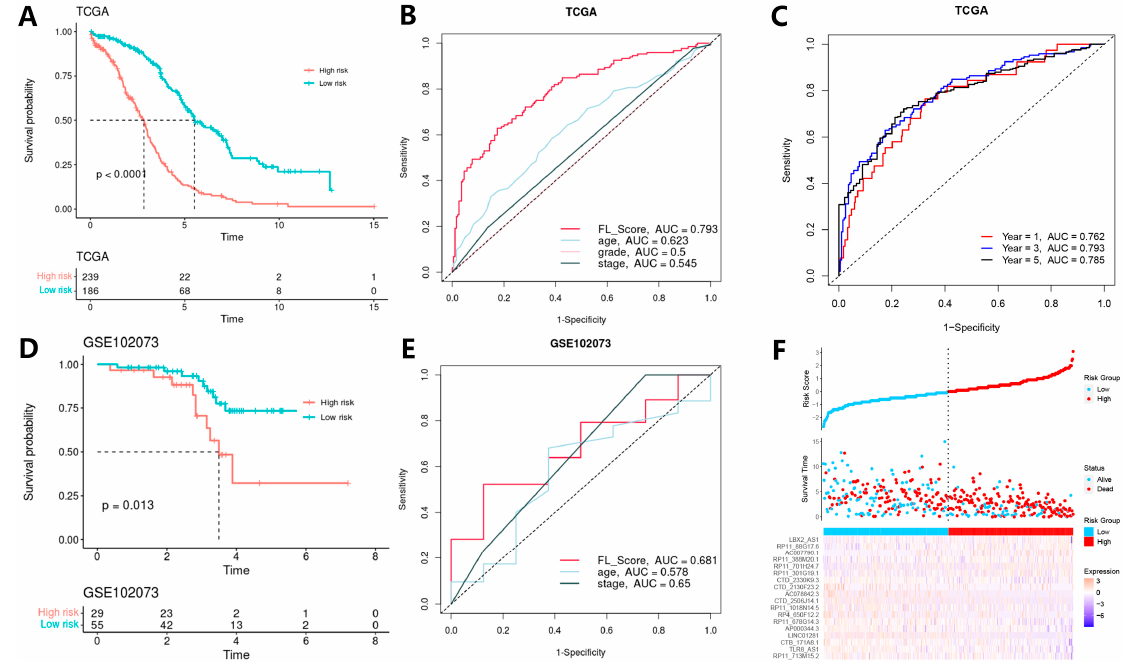
Figure 4. Results of model validation in the training and validation cohorts. ( A ) Kaplan–Meier (KM) survival analysis in the training cohort. ( B ) Receiver operating characteristic (ROC) curves for 3-year survival. ( C ) ROC curves for ferroptosis-related lncRNA score (FL_Score). ( D ) KM survival analysis in the validation cohort. ( E ) ROC curves for 5-year survival. ( F ) Risk survival status plot for the training